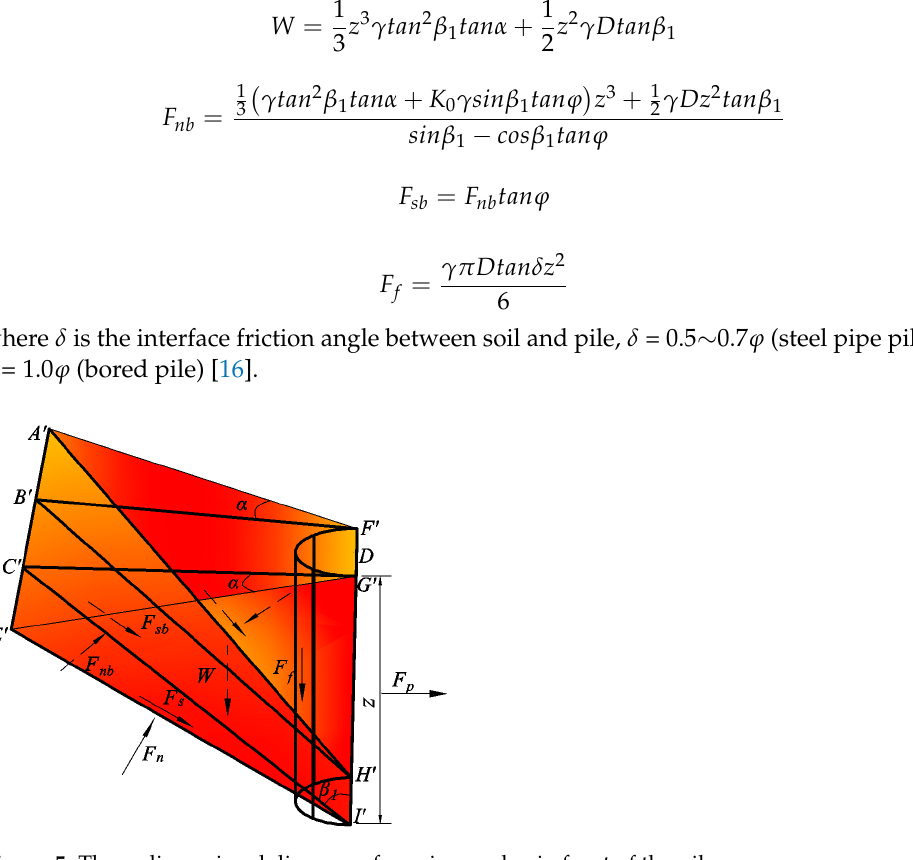
Figure 5. Three-dimensional diagram of passive wedge in front of the pile.